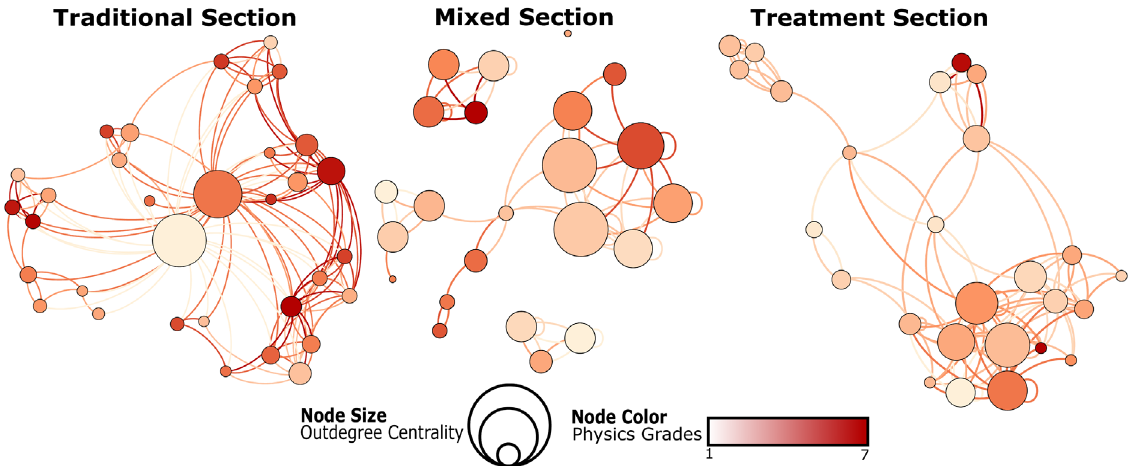
FIG. 3. Classroom networks for the three analyzed sections: traditional, mixed, and treatment. Node color represents physics grades (dark red being the highest), and the node size represents the out-degree centrality, i.e., the number of times that a student seeks information in the